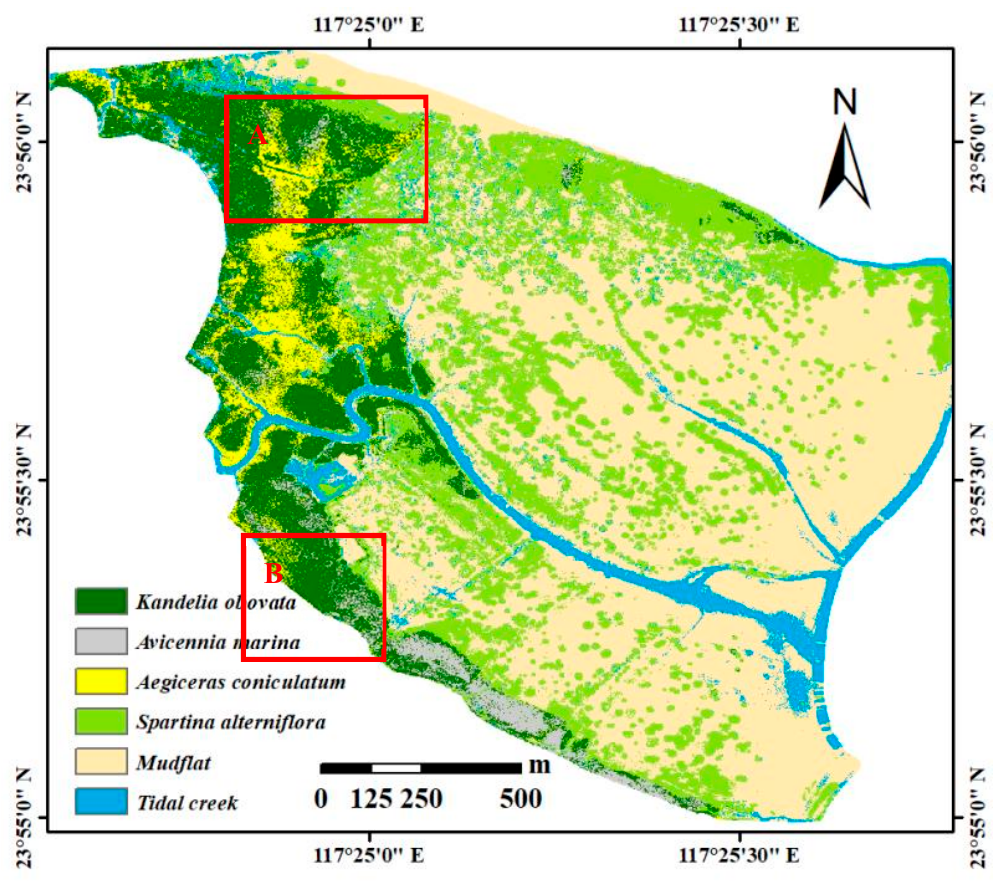
Figure 9. UAV-based high resolution mangrove species map [26] .